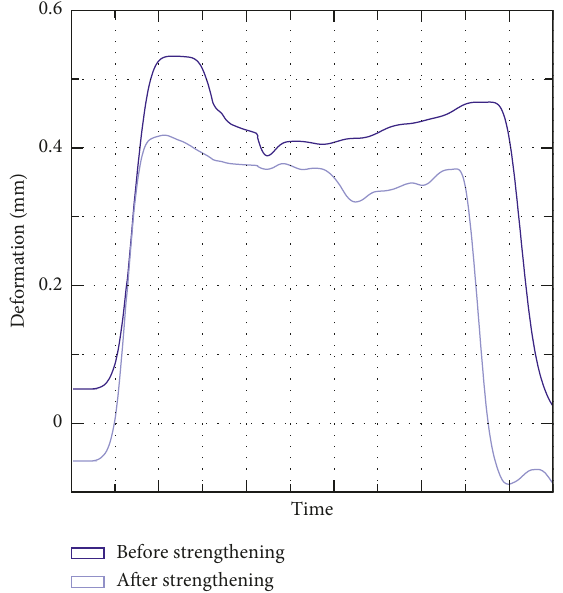
Figure 25: A comparison of the measured deflections of the main girder before and after the strengthening with the same test vehicles in the same position on the U-shaped bridge built in Vraˇzn´e in 1928 [23].